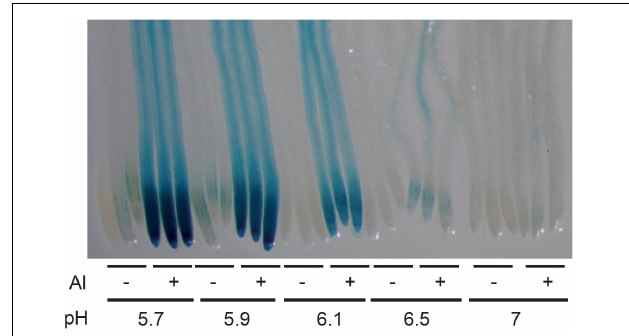
FIGURE 1 | Effect of pH and aluminum (Al) on the expression of ALMT1 in the root tip. Four day-old WT seedlings (carrying the pALMT1:GUS reporter) were grown on a phosphate-rich medium and transferred on the indicated P 10 Fe 0 medium supplemented or not with 20 µ M AlCl 3 and buffered at the indicated pH. After 3 days a GUS staining was performed on roots for 1 h. Three representative root tips are shown per condition.